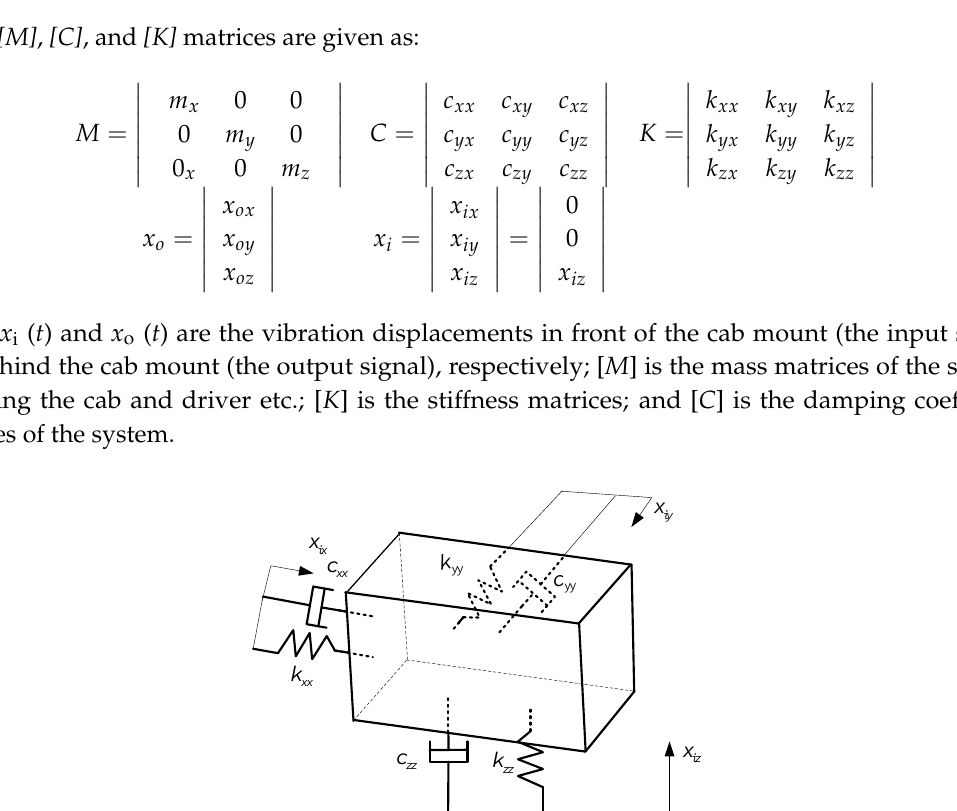
Figure 7. Vibration model of the cab mount system.